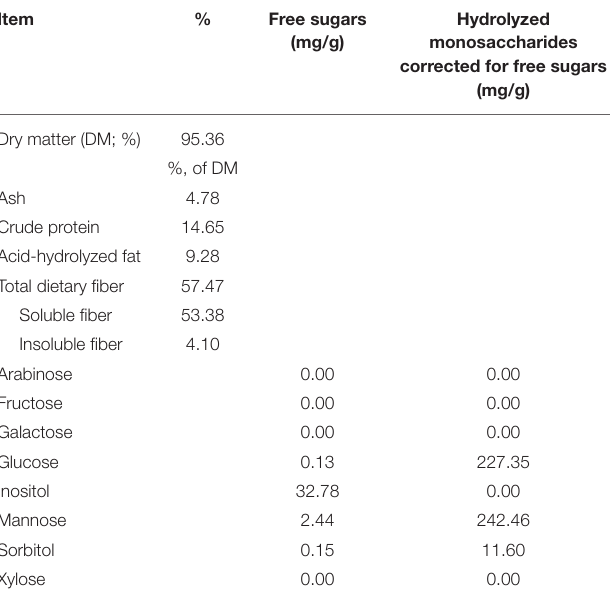
TABLE 3 | Analyzed chemical composition of the yeast cell wall fraction tested.